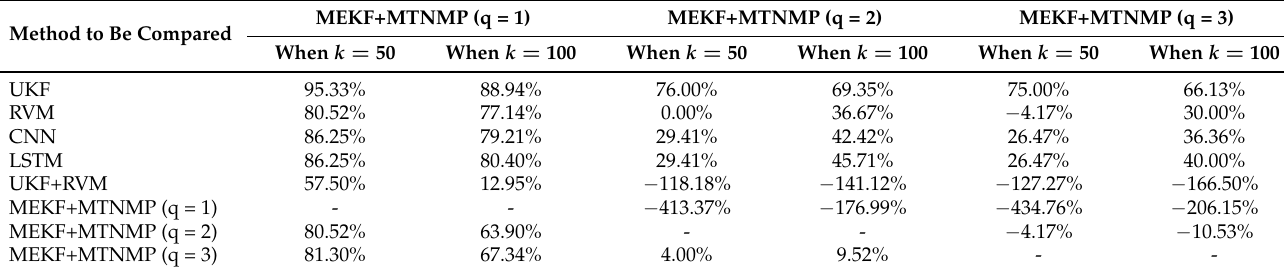
Table 7. Comparison of methods in the B0007 experiment.